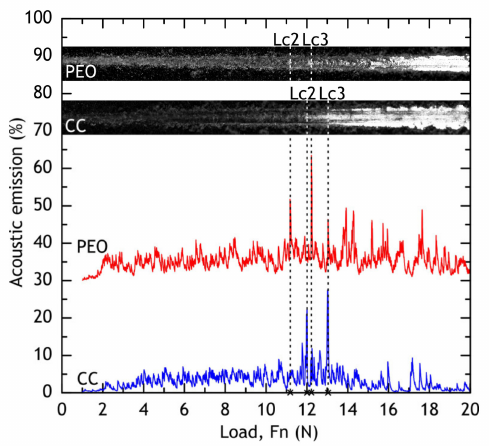
Figure 9. Micrograph of a full scratch, critical loads, and acoustic emission of PEO and composite